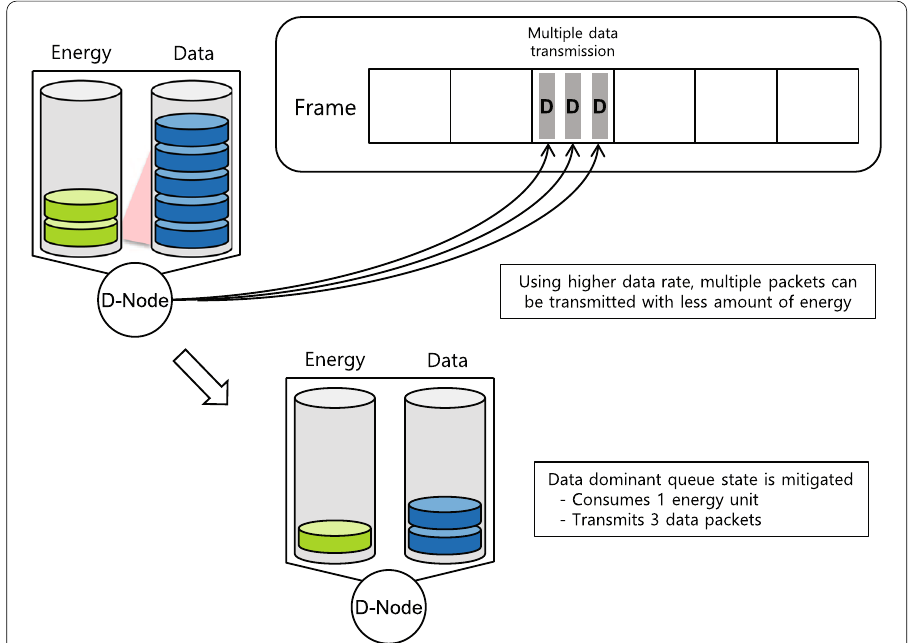
Fig. 2 High‑rate operation and the effect of the